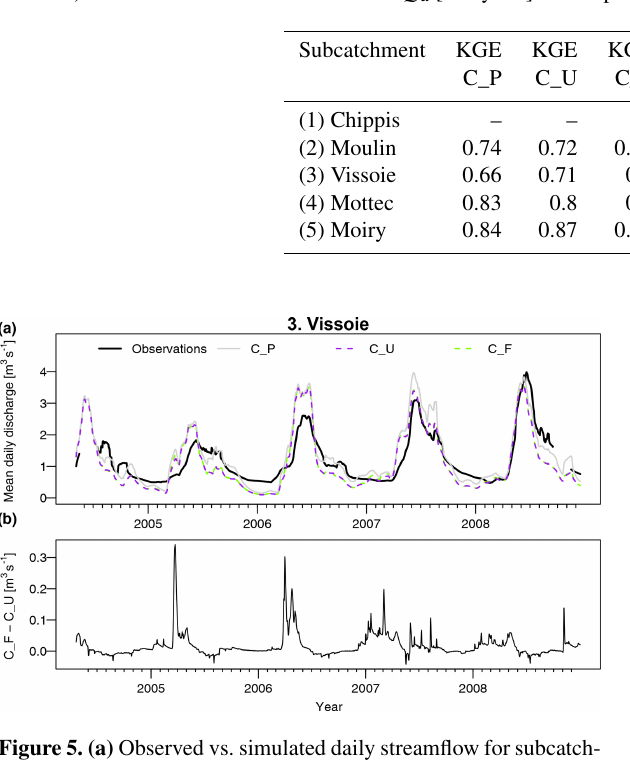
Table 3. Kling–Gupta Efficiency (KGE) scores obtained by three different model configurations – standalone PREVAH (C_P), uncoupled FORHYCS (C_U), and fully coupled FORHYCS (C_F) – against daily observed streamflow data for the period 2004–2008 (first three columns) and mean annual streamflow sums Q a [mmyr − 1 ] for the period 2005–2007 (observed and simulated).